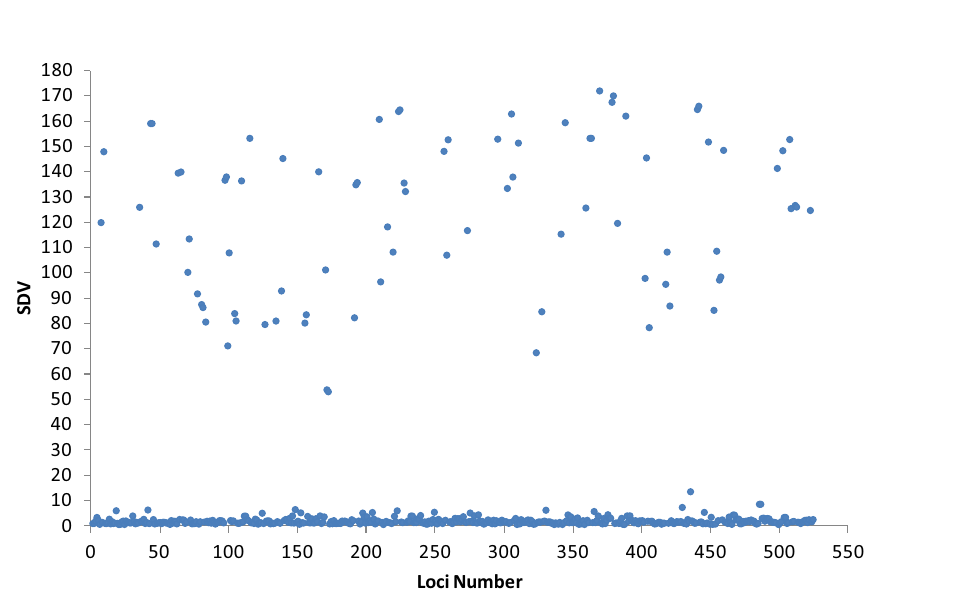
Table 2. Test of selection type in deviated hk × hk markers.